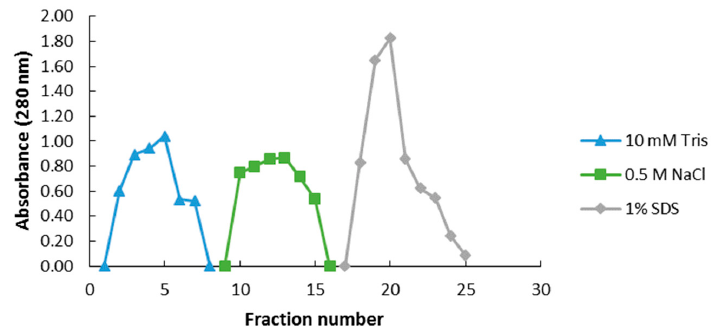
Figure 5. Representative elution profile of binding events between ergosterol-hemisuccinate immobilized on EAH Sepharose 4B resin and A. thaliana PM-associated proteins for the 6 h time point. The blue curve represents the flow-through fractions removed with 10 mM Tris-HCl, pH 7.5 buffer. The green curve represents the non-specifically bound fractions removed with 0.5 M NaCl in buffer, and the grey curve represents the proteins of interest eluted with 1% SDS in buffer.